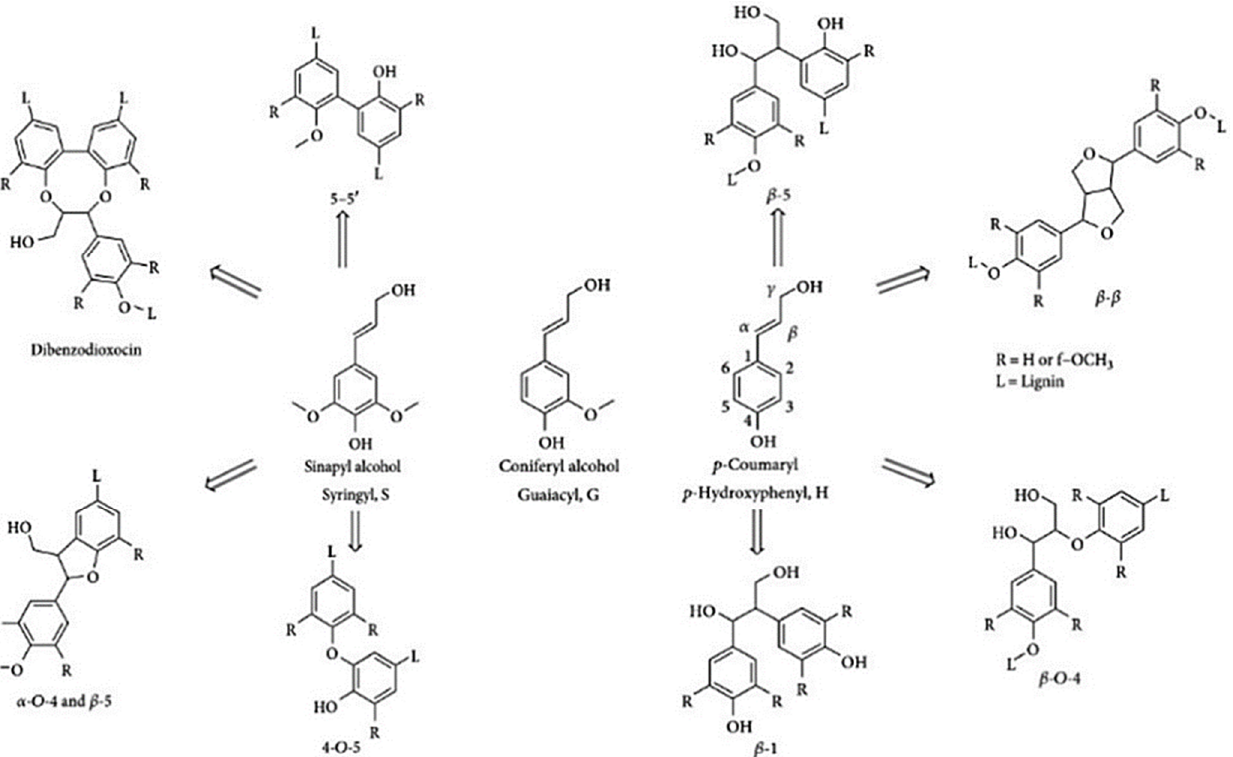
Figure 3. Lignin monolignols and common chemical bonds involved in the formation of lignin polymeric structure.